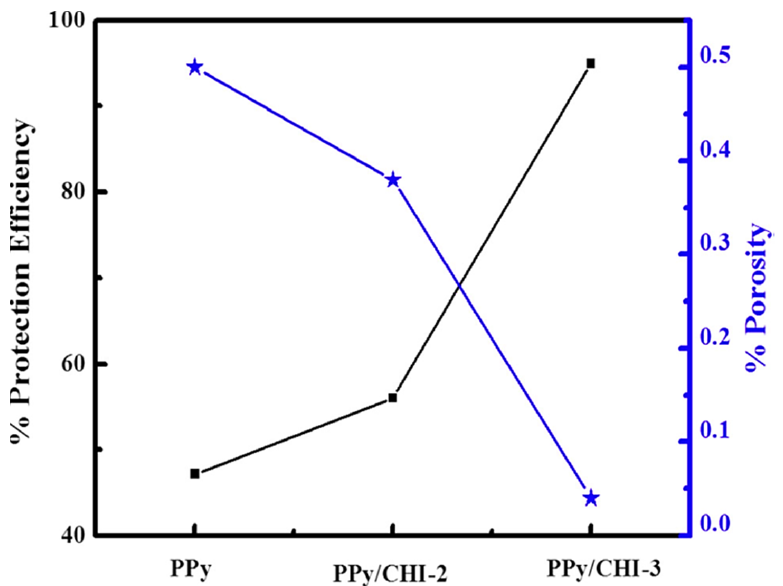
Figure 8. Protection efficiency and porosity results for PPy and PPy/GO nanocomposite-coated Ti [102]. PPy = polypyrrole; Ppy/GO = polypyrrole/graphene oxide. Reproduced with permission from Springer.